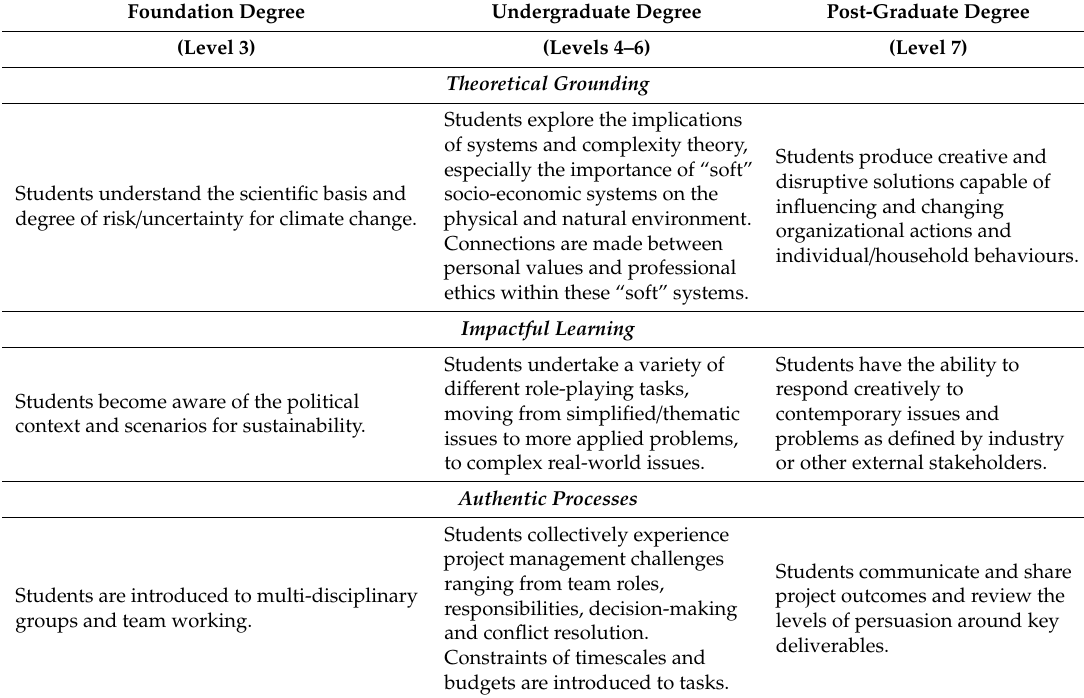
Table 2. Learning activities and outcomes for sustainability